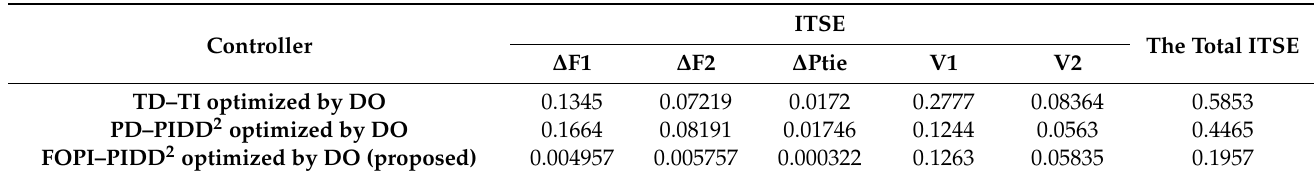
Table 8. Dynamic specifications of the investigated system represented as ITSE value using different controllers under scenario 6 impact.